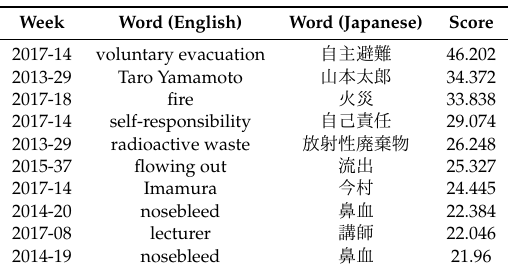
Table 4. Top 10 pairs of words and timings, for which the scores calculated using the proposed method were